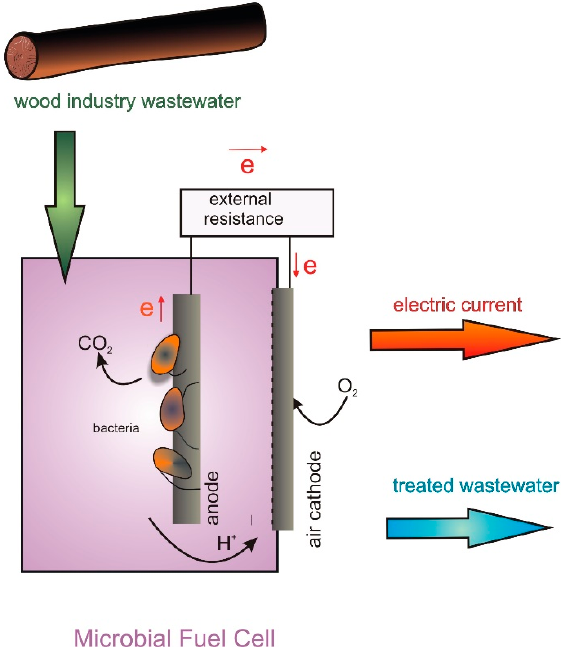
Figure 1. Schematic representation of the production of electric current from hydrothermal treatment wastewater (WHTW) in a single-chamber air-cathode microbial fuel cell (MFC) with simultaneous treatment of wastewater.